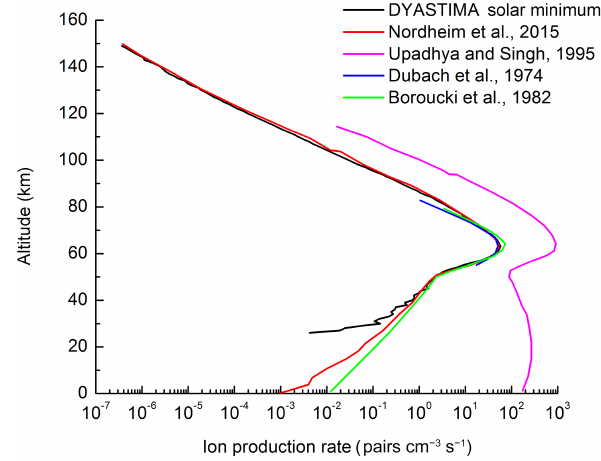
Figure 3. Ionization rate profiles in the Venusian atmosphere, as a function of altitude, derived with the DYASTIMA application. The interactions of the galactic cosmic rays with the gas were examined for both solar minimum and solar maximum conditions.